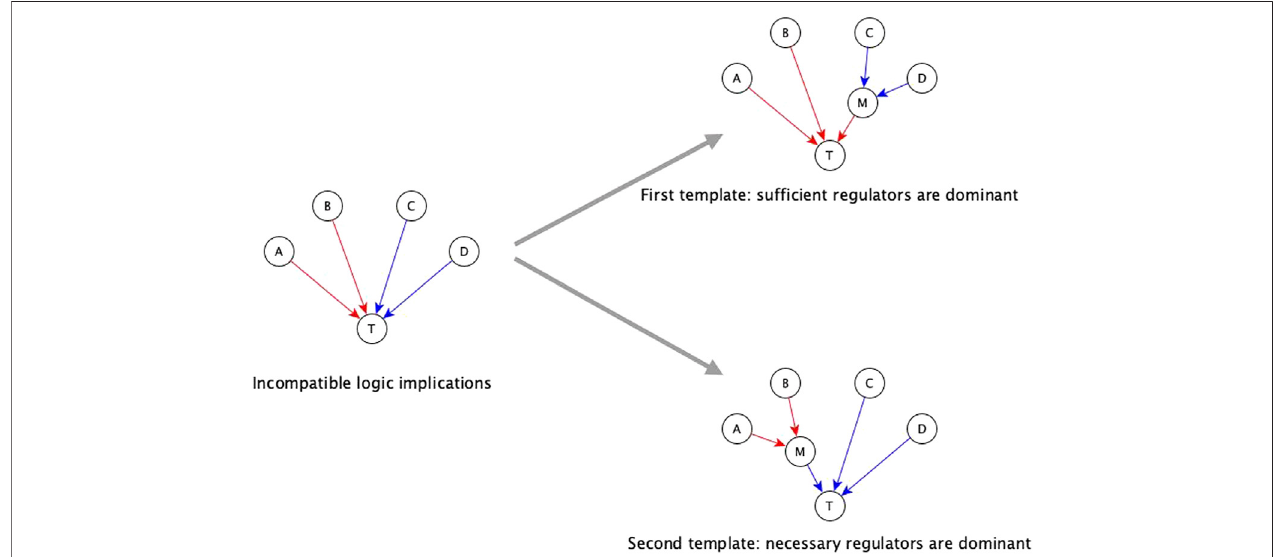
FIGURE3| Dominantregulatorsmethodfortheresolutionofincompatiblelogicimplications.Rededgesindicatesuf fi cientcausallogicimplicationwhileblueedges indicate necessary causal logic implication. In this example, regulators A and B are suf fi cient while regulators C and D are necessary for the target node T — this is an incompatiblecombinationoflogicimplications.Thetwotemplatesforresolvingthisbythedominantregulatorsmethodareshownontheright.Thetop-rightcaseshows the fi rst template where suf fi cient regulators are considered to be dominant, hence, the necessary regulators are grouped together, and this group is marked as suf fi cient.Inthiscase,nodeMisamediatornodethatissuf fi cientforT.TheBooleanruleforthetargetnodeis:T*=AorBor(CandD),whichisequivalenttoT*=AorBor M; where M* = C and D. The bottom-right case shows the second template where necessary regulators are considered to be dominant, hence, the group of suf fi cient regulators is marked as necessary. In this case, M is a mediator node that is necessary for T. The Boolean rule for the target node is: T* = (A or B) and C and D which is equivalent to T* = M and C and D; where M* = A or